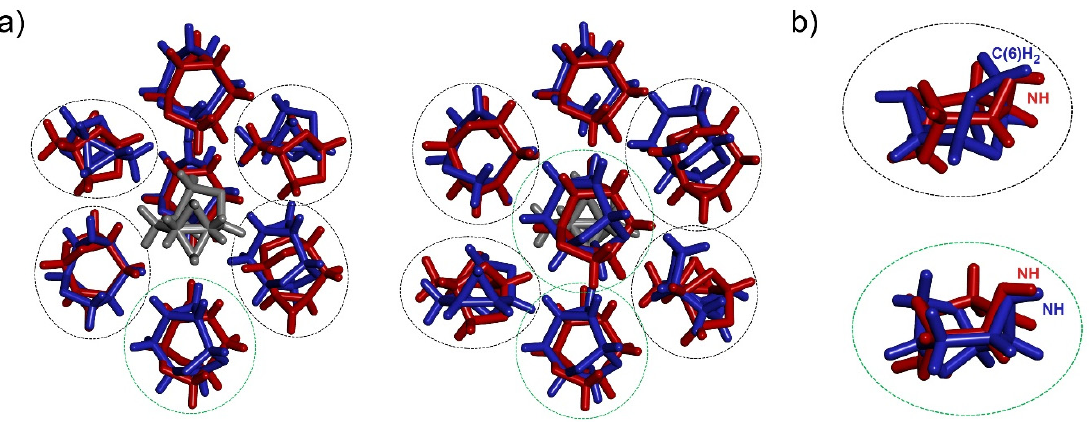
Figure 11. An overlay of molecular arrangements around I (red) and VIa (blue), molecules in the back (left) and in the front (right). Parent molecules are depicted in gray ( a ). Dashed circles indicate different orientation of the molecules switching in interaction CH 2 and NH group (black) and positioning NH group to the same location (green). Detail of the different orientation of the molecules ( b ).